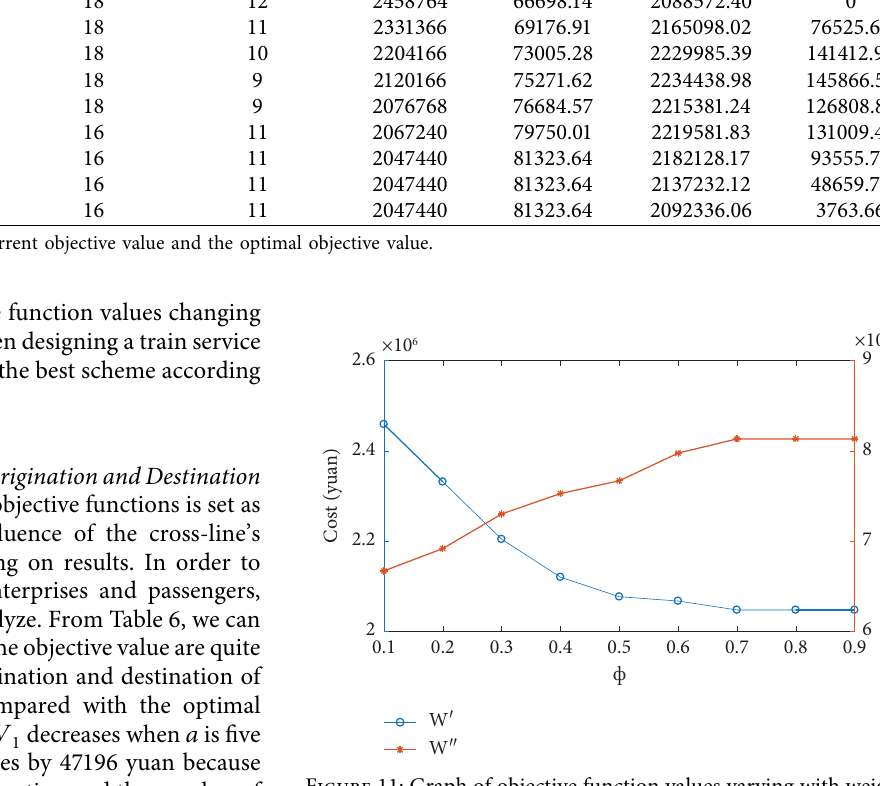
Figure 11: Graph of objective function values varying with weight